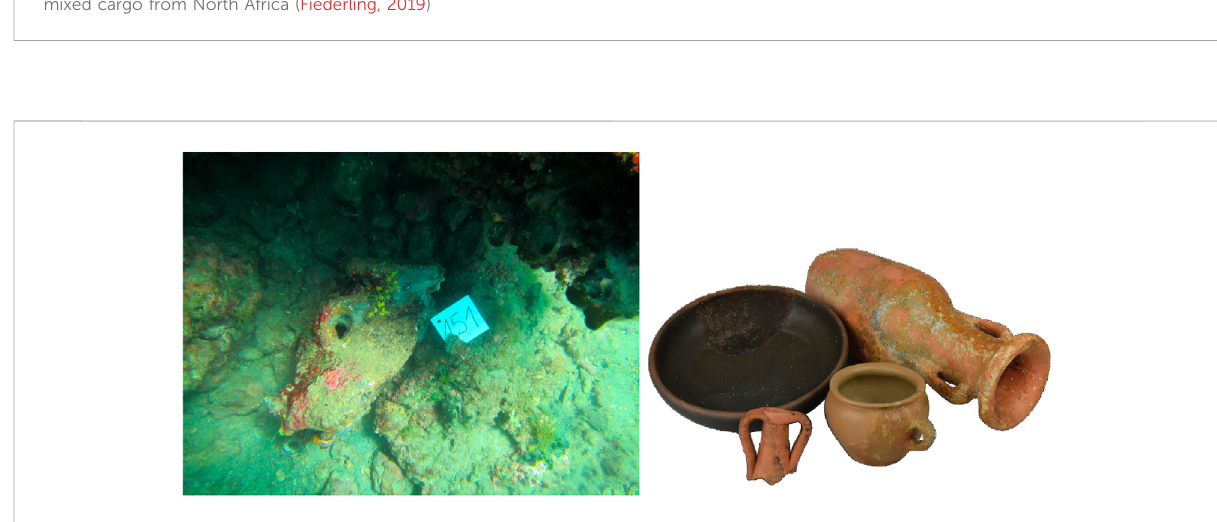
FIGURE 5 Cargo — in situ (left) and reconstructions (right) (Fiederling,